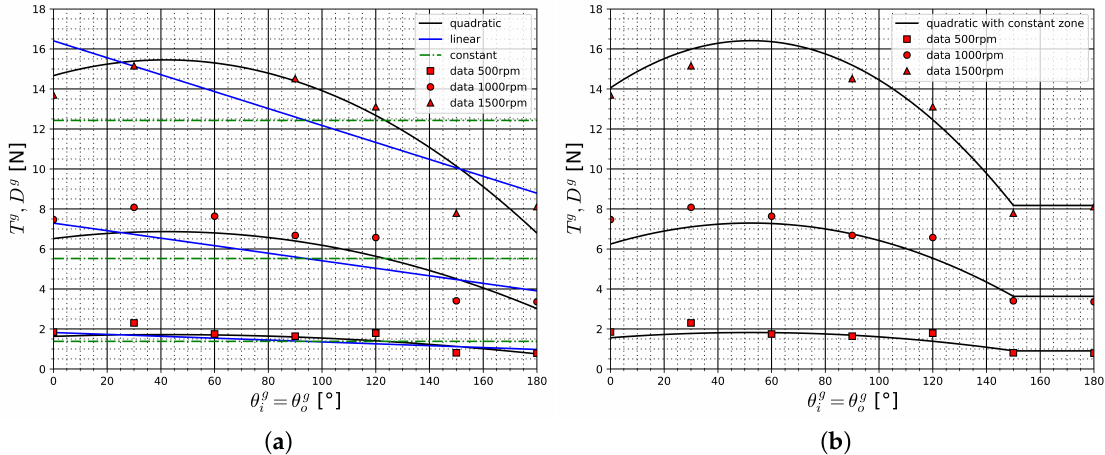
) with T m ( n ) = T nn n 2 , and ( b ) a quadratic i